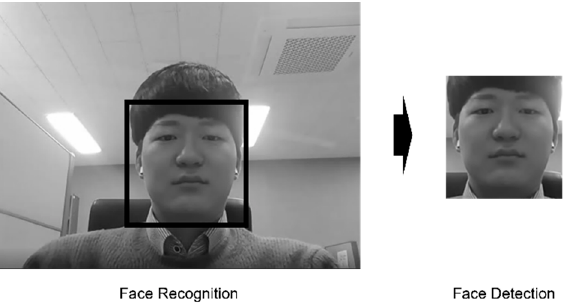
Figure 2. Face recognition and detection. Table 4. Face data about 𝑖𝑡𝑒𝑚 𝑗 .